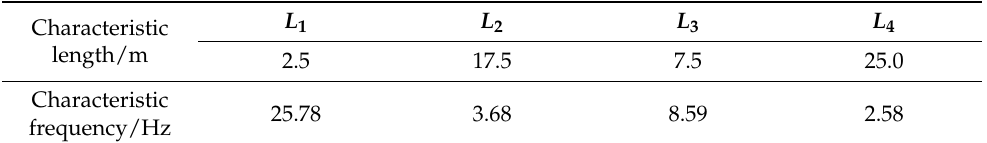
Table 5. Geometric characteristics and the associated frequencies when the running speed is 232 km/h.